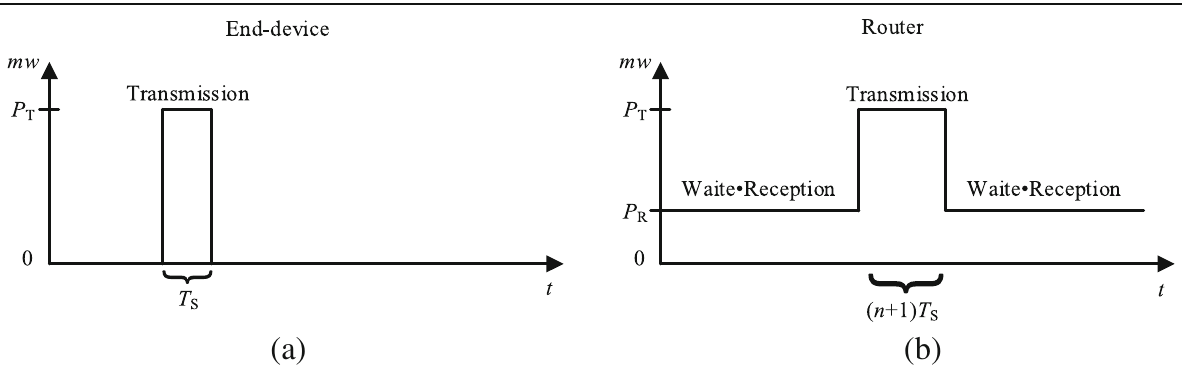
Fig. 3 Time series of network operation. This figure shows the time series of the operation of WSNs, where a shows the time series of the operation of the end-device, b shows the time series of the operation of the router, T s is the transmission time, P T is the transmission power, P R is the reception power, and n is the number of child nodes of the router. Here, the end-device enters a sleep mode when no information is transmitted, while the router waits for a receivable state when no information is transmitted